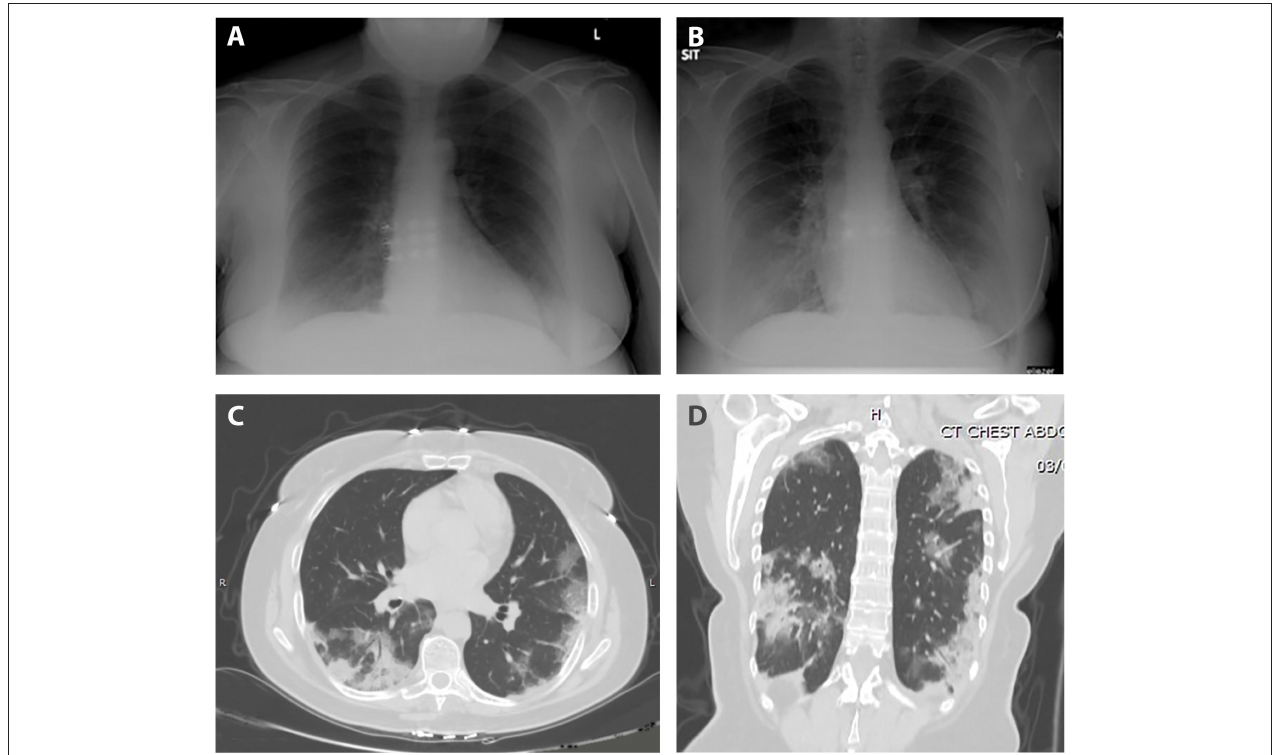
FIGURE 2 | Anteroposterior chest radiograph; (A) normal on admission, (B) on day 8 of hospitalization with bilateral basal infiltrates. Axial (C) and coronal (D) sections CT scan; bilateral multifocal peripheral pulmonary ground glass opacities and consolidations typical for COVID19